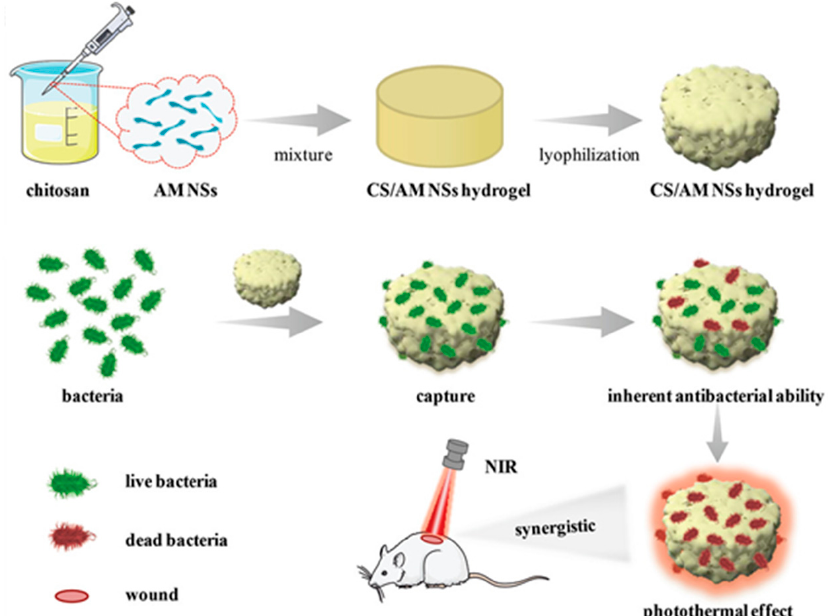
Figure 2. The schematic representation of the preparation of CS/AM NSs hydrogel and its application towards the bacterial wound treatment on the mice, adopted from [31] with permission from Wiley through copyright clearance center.